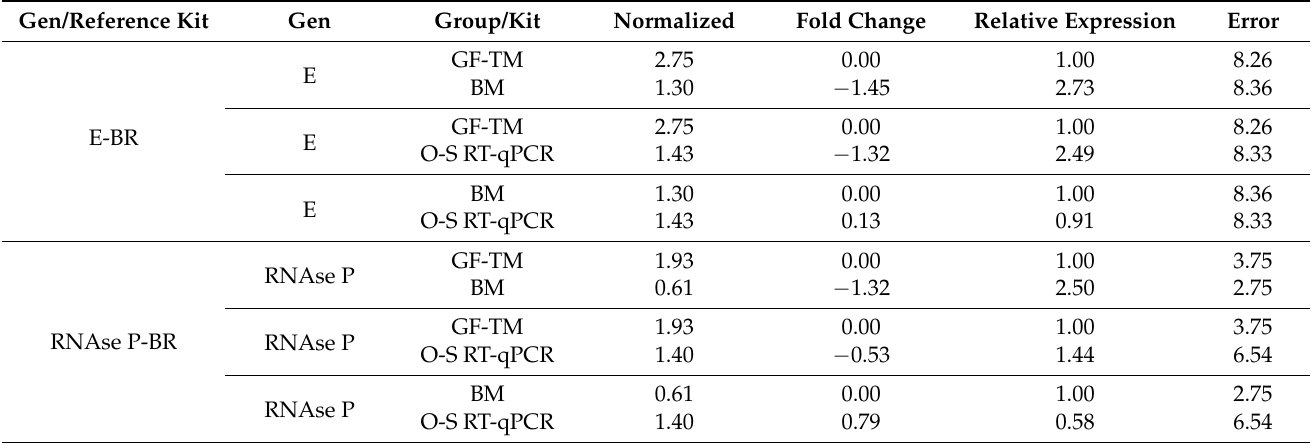
Table 4. Fold change of fluorescence levels for genes E and N in three kits assessed in comparison to BR.